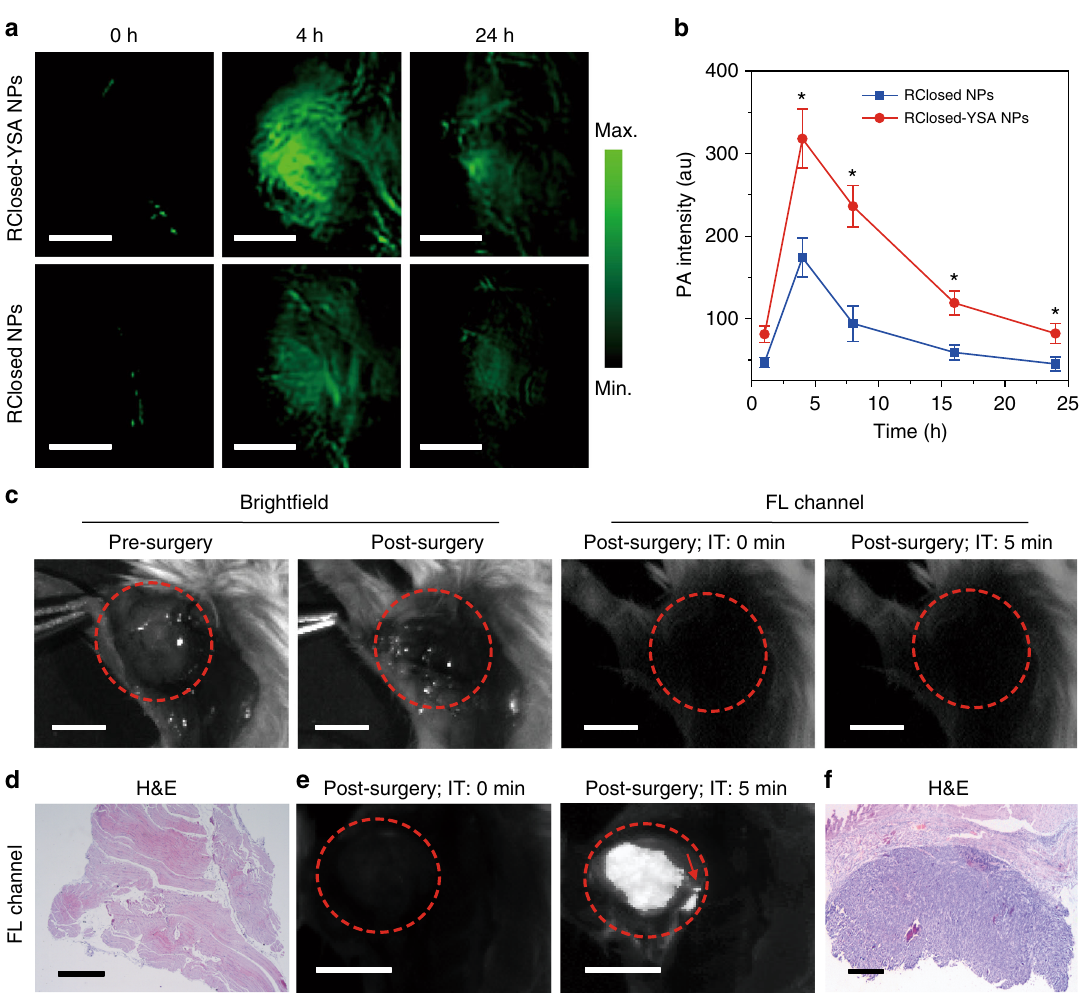
Fig. 6 In vivo preoperative PA imaging and intraoperative fl uorescence imaging. a Representative time-dependent PA images of subcutaneous tumours from mice intravenously injected with RClosed-YSA and RClosed NPs (800 μ M based on RClosed-DTE-TPECM, 100 μ L), respectively. Scale bars, 2 mm. b Plot of PA intensity at 700 nm in tumour versus time post injection of RClosed-YSA or RClosed NPs. Error bars, mean ± s.d. ( n = 3 mice per group). * P < 0.05, in comparison between RClosed-YSA and RClosed NPs using unpaired Student's t -test (two-tailed). c Representative bright fi eld images of RClosed- YSA NP-treated tumour-bearing mice before and after surgery as well as representative fl uorescence images of mice with complete surgical resection of tumours, followed by 610 nm red light (0.3 W cm − 2 ) irradiation at the operative incision site for 5 min. Scale bars, 3 mm. FL fl uorescence, IT irradiation time. d H&E stained tissues at the operative incision site in c indicate no residual tumours left behind. Scale bar, 1 mm. e Representative fl uorescence images of RClosed-YSA NP-treated mice with residual tumours post surgery. The operative incision site was irradiated by 610 nm red light (0.3 W cm − 2 ) for 5 min. The red dashed circles in c and e indicate the tumour/operative incision site. The red arrow shows the residual tumours with a diameter below 1 mm. Scale bars, 3 mm. f , H&E stained tissues at the operative incision site in e con fi rm the existence of residual tumours. Scale bar, 0.5